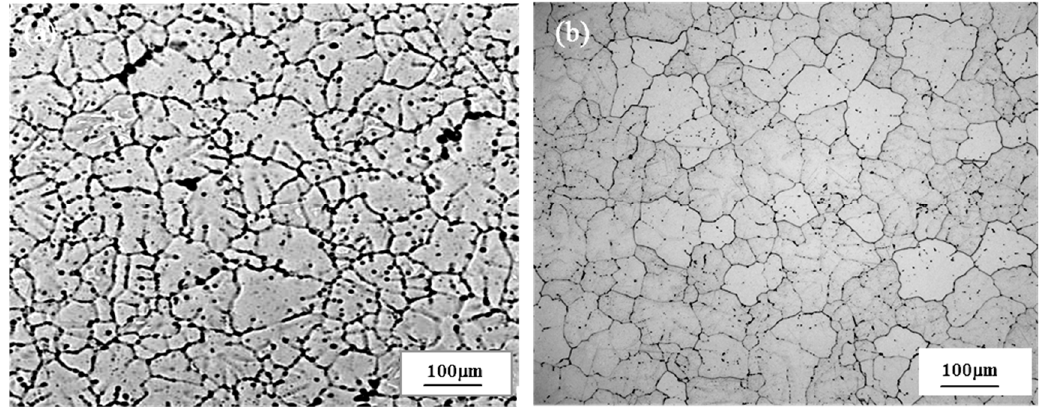
Figure 1. Microstructures of composite modified 6063 aluminum alloy: ( a ) as-cast; ( b ) homogenized.